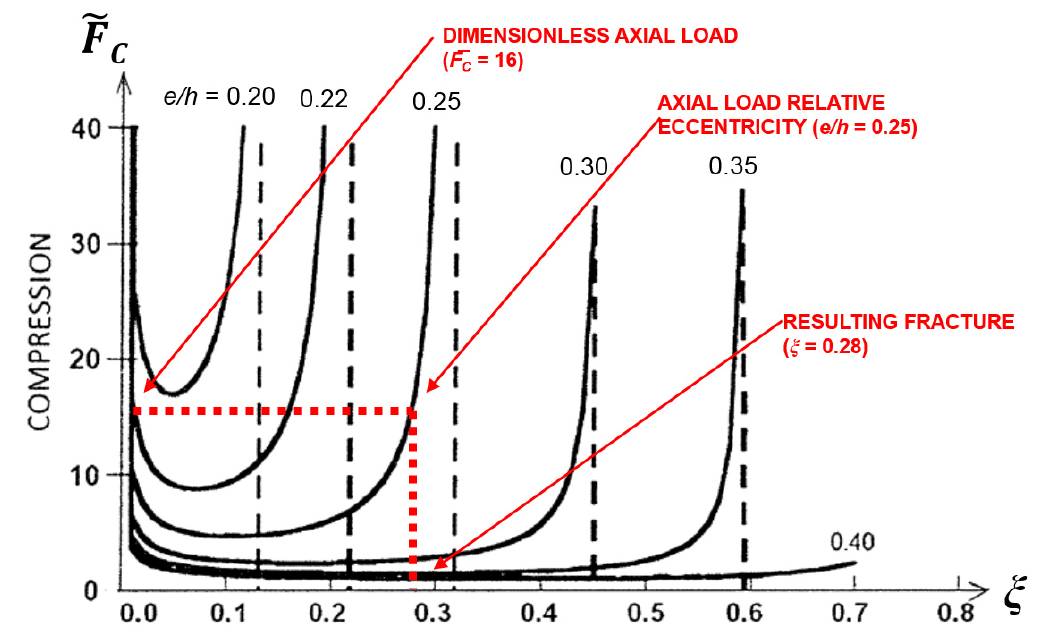
Figure 4. Mechanism of crack opening for off-center compression (arch-structure fracturing process): case of an axial force corresponding to (cid:101) F C = 16, with a relative eccentricity e / h = 0.25, leading to a relative crack depth in the cross-section ξ = 0.28 (dotted line).